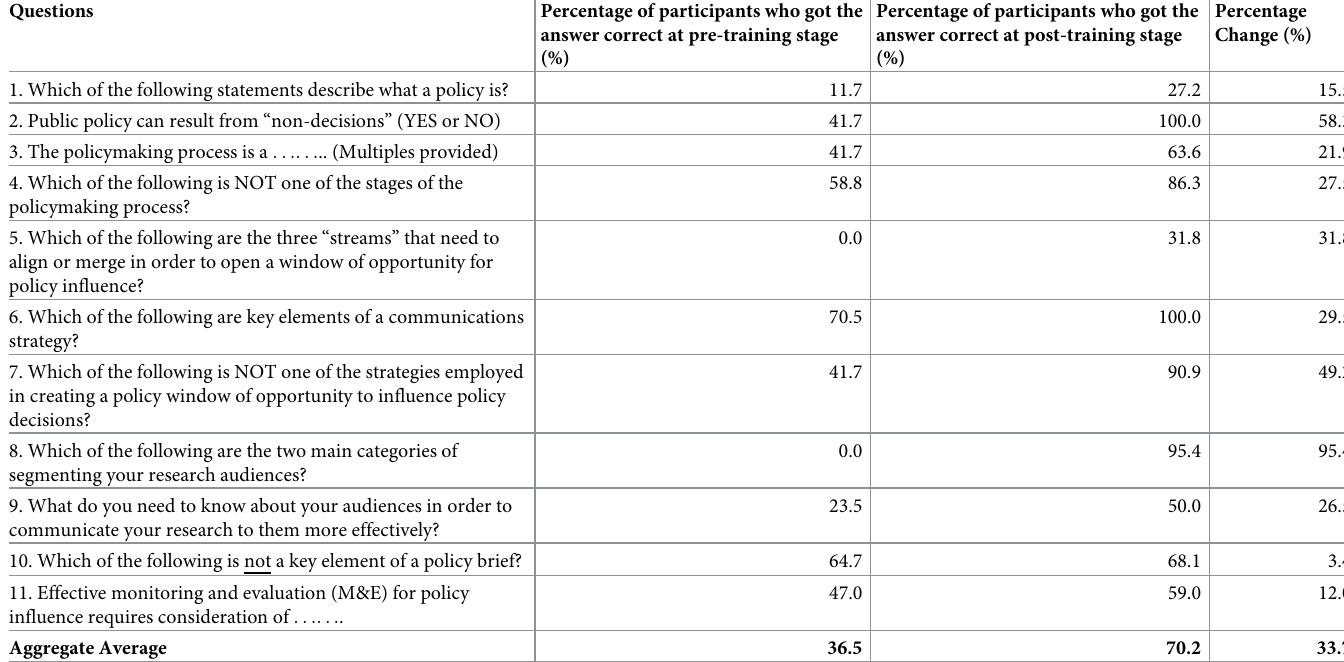
Table 7. Results of questions assessing knowledge acquired through